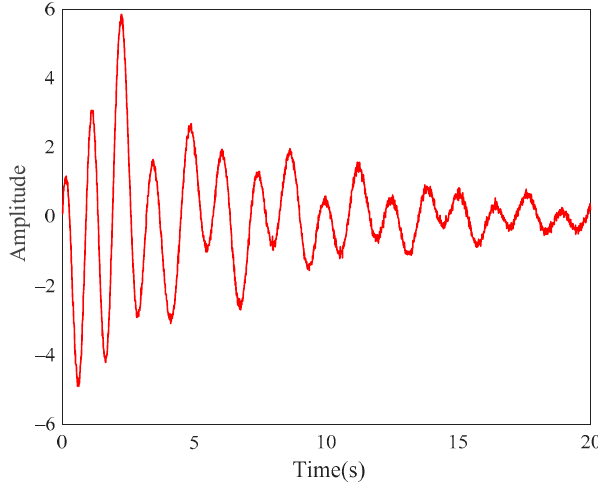
Figure 3. Simulated signal A with Gaussian white noise at 30 dB SNR.